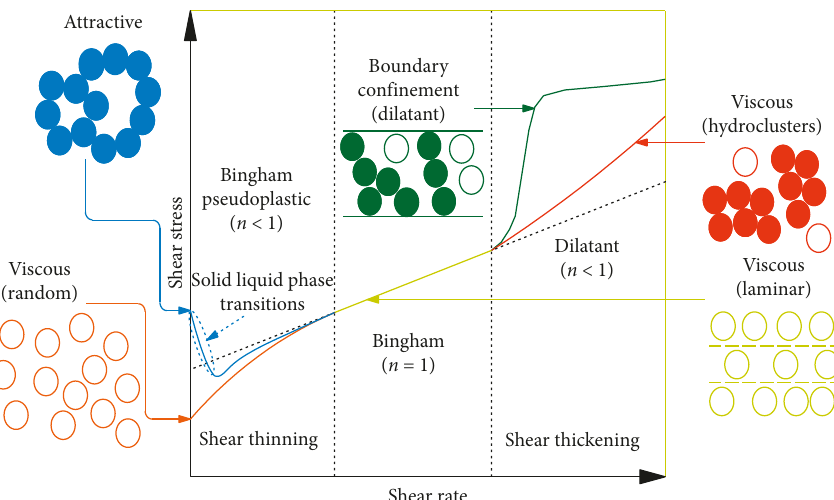
Figure 7: Change in the microstructure of CPB explains the transition to shear thinning and shear